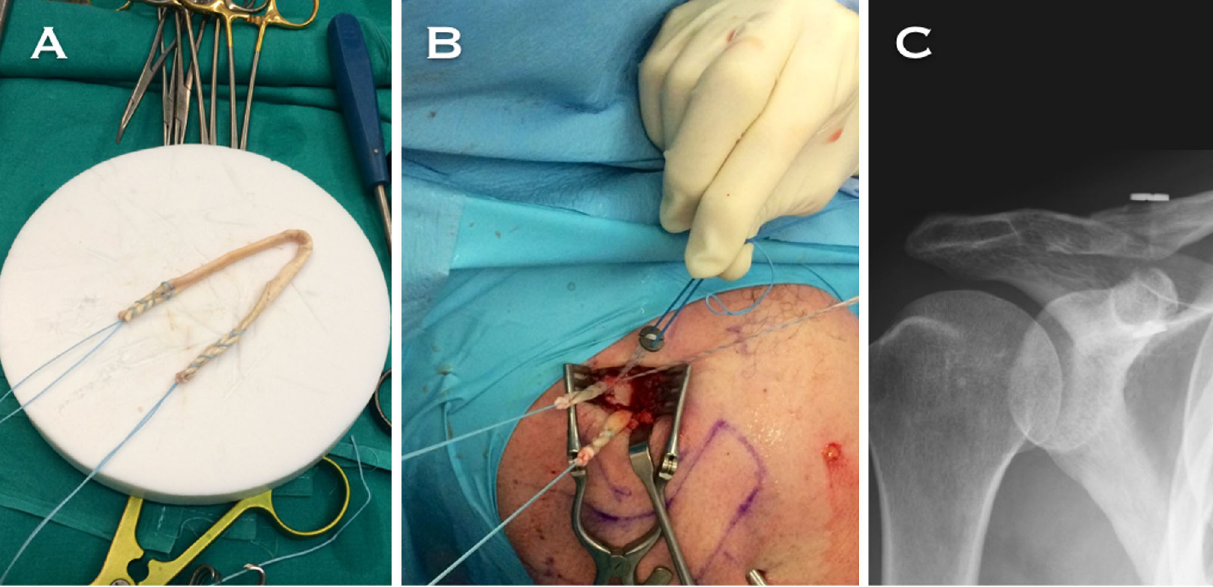
Fig. 3 a Semitendinous allograft after being sutured with a metal- core suture in both of its limbs. b Both limbs of the graft coming out of the clavicle once fixed in both tunnels with bio-tenodesis interference screws. The ZipTight is tied by threading the sliding suture in the washer. c AP X-ray of a right shoulder in which an